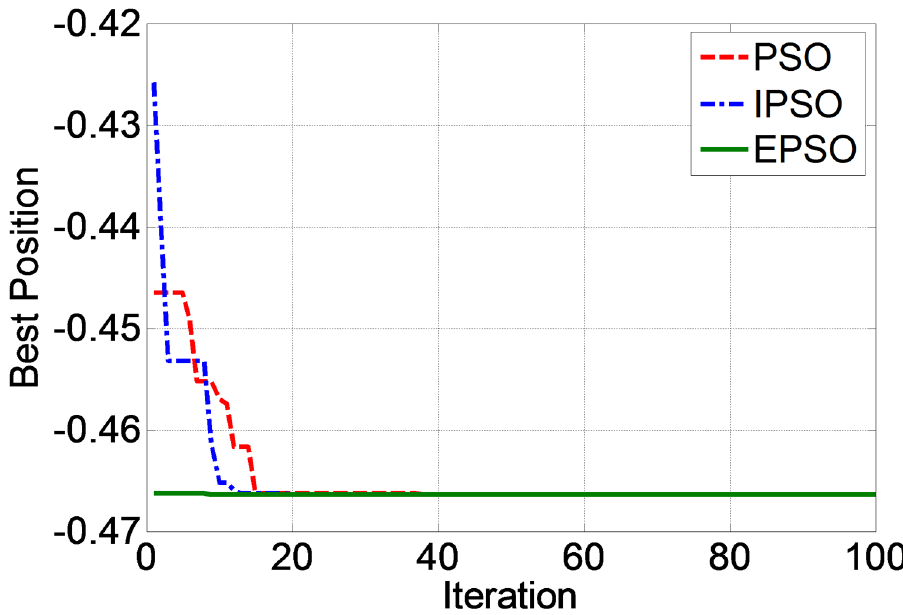
Fig 3. Best position vs. iteration for PSO, IPSO and EPSO techniques.